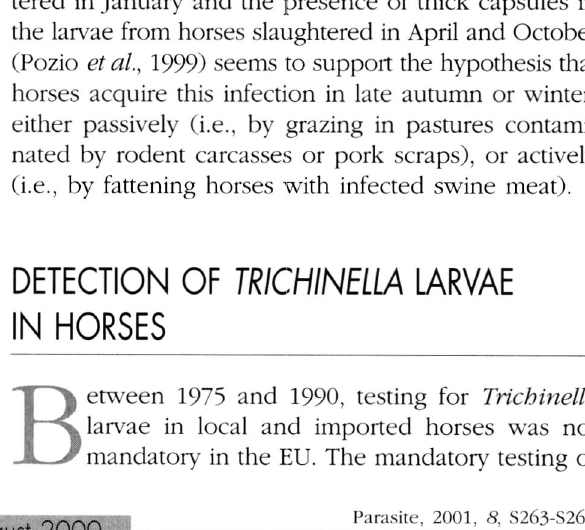
NATURAL TRANSMISSION